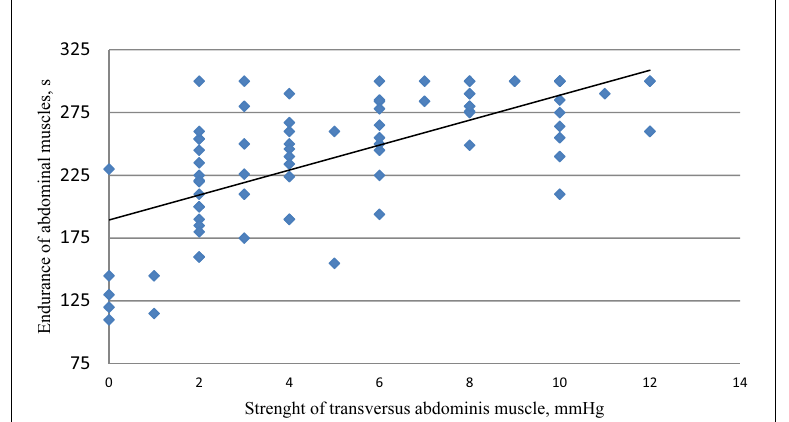
Note. r = 0.72; p < 0.001. subjects